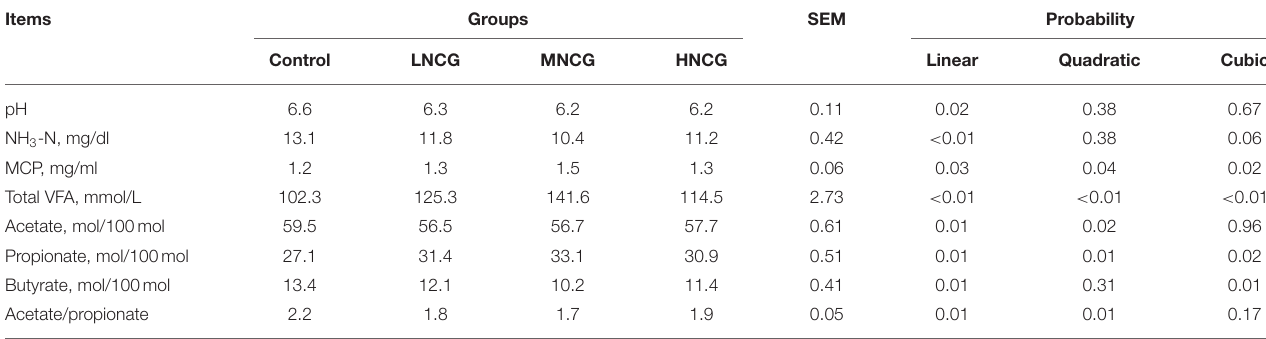
TABLE 1 | Effects of NCG supplementation on ruminal fermentation patterns of lactating dairy cows under heat stress. Items Groups SEM Probability Control Linear